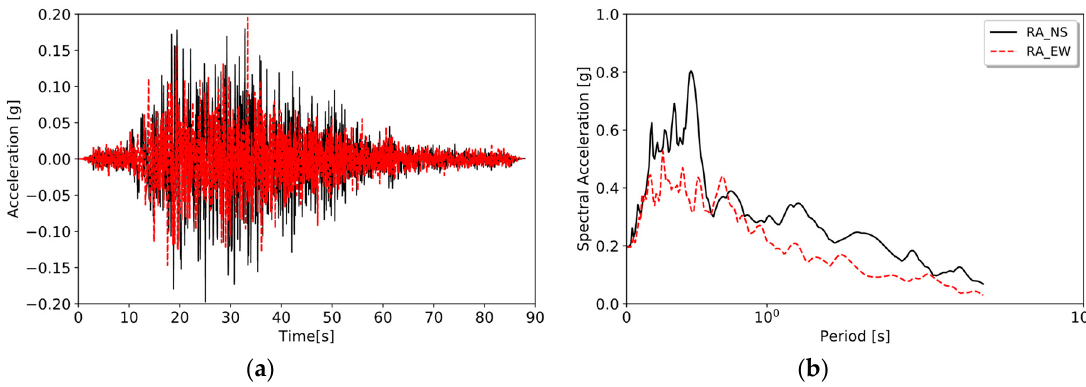
Figure 16. ( a ) North-South (NS) and East-West (EW) acceleration time histories for the Rapel station, ( b ) spectral acceleration (5% damping) of the NS and EW components for the Rapel station.